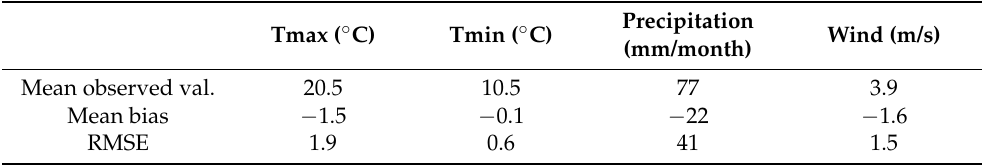
Table 3. Mean observed value, mean bias and Root Mean Square Error (RMSE) of the model for maximum and minimum temperature, precipitation, and wind, averaged over the whole past period considered. Tmax ( ◦ C) Tmin ( ◦ C) Mean observed